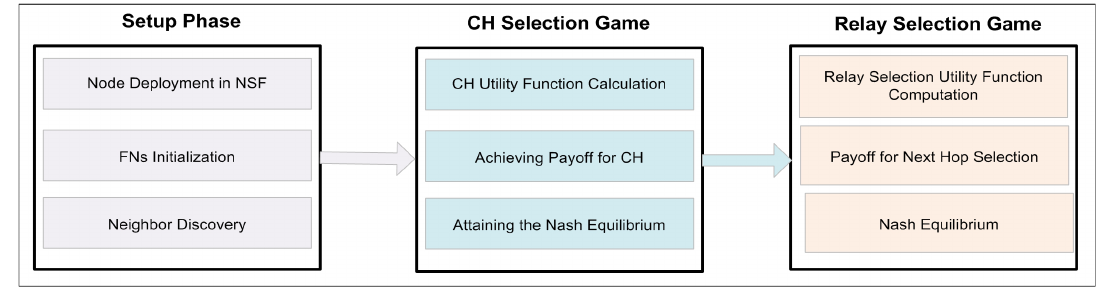
Figure 1. The flowchart of the proposed